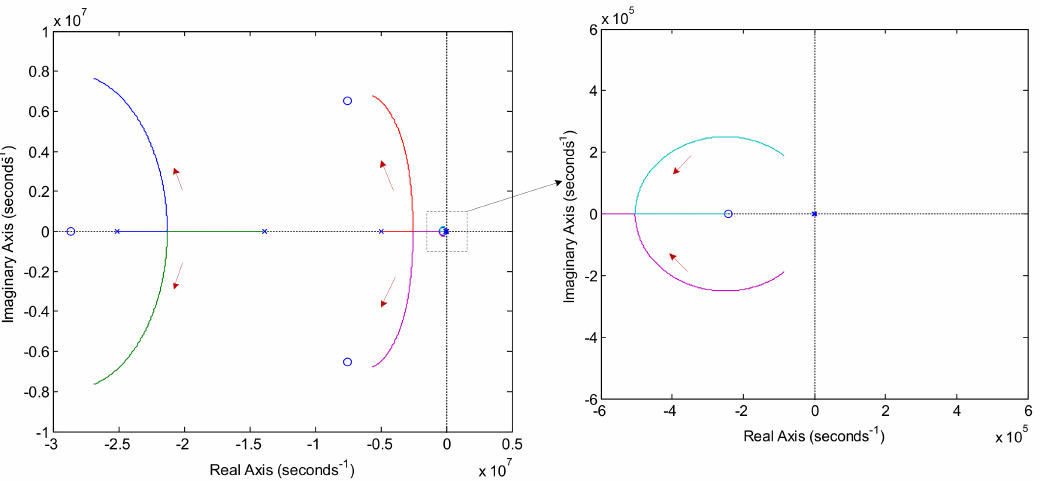
Figure 10. The root locus of the power